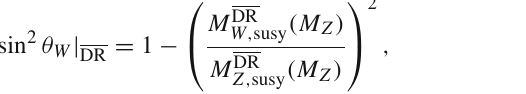
Fig. 4 Sensitivity of the proton decay rate to sin 2 θ W | 0.2312 to 0.2315 (upper and lower black dashed lines). As in the previ- ous figure, the solid black contour shows the contour τ( p → K + ¯ ν) = 0 . 066 × 10 35 years for central values of the inputs, and the dotted black contour shows the shift in this limit due to the σ tot uncertainty. The solid brown curve shows the corresponding contour calculated using sin 2 θ W = 0 . 2325 in the MS